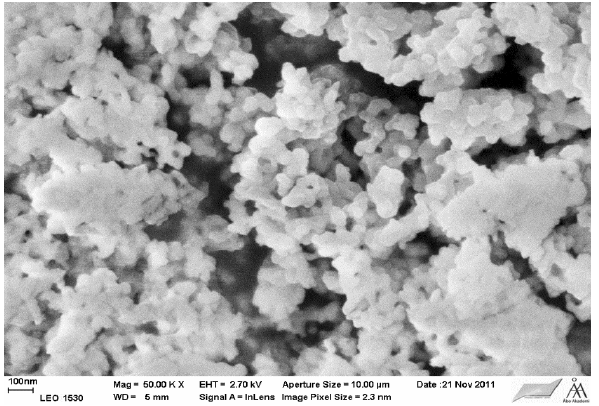
Figure 2. Scanning electron micrograph (SEM) of 16 wt % Ce–H–MCM-41.